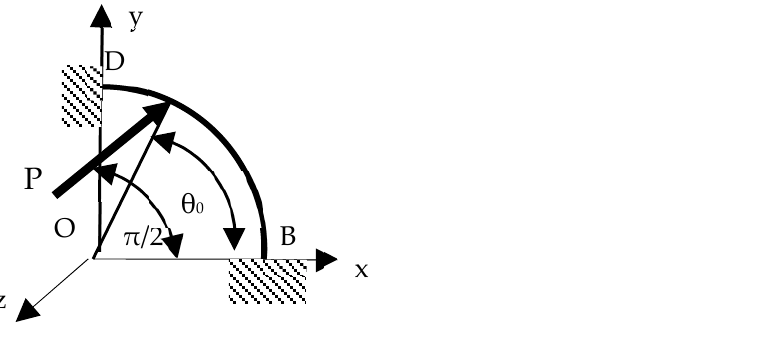
Figure 3. A spring element with axes and unit vectors. In the current point A(s) of the middle fiber of the spring, the mobile triad ( ) kji   ,, is directly associated, so that i  and j  are unit vectors along the tangent and normal to